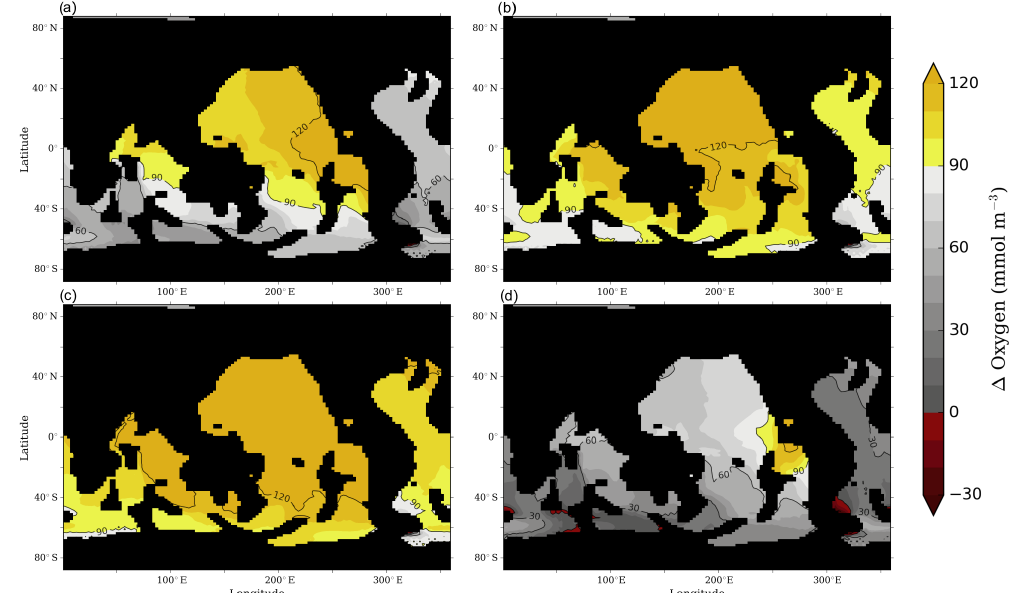
Figure 13. Change in oxygen concentration (mmolm − 3 ) at 3500m between the LGM and PI for the experiments with modified biogeo- chemical formulations. (a) O-LGM BGC poc − O-PI, (b) O-LGM BGC rem − O-PI, (c) O-LGM BGC 3500m is representative of the deep ocean. It should be noted that the oxygen field for experiment O-LGM BGC ganic carbon was set to zero, did not differ from the unmodified glacial experiment O-LGM and can therefore be used here as a reference to that